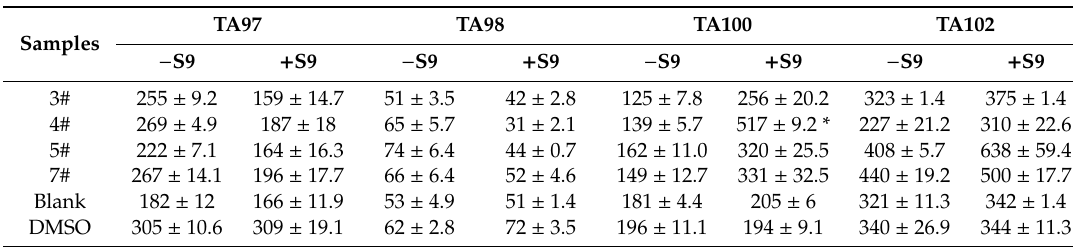
Table 6. Reverse mutation colonies of four strains detected by overlying water after remediation in the presence and absence of liver microsomal